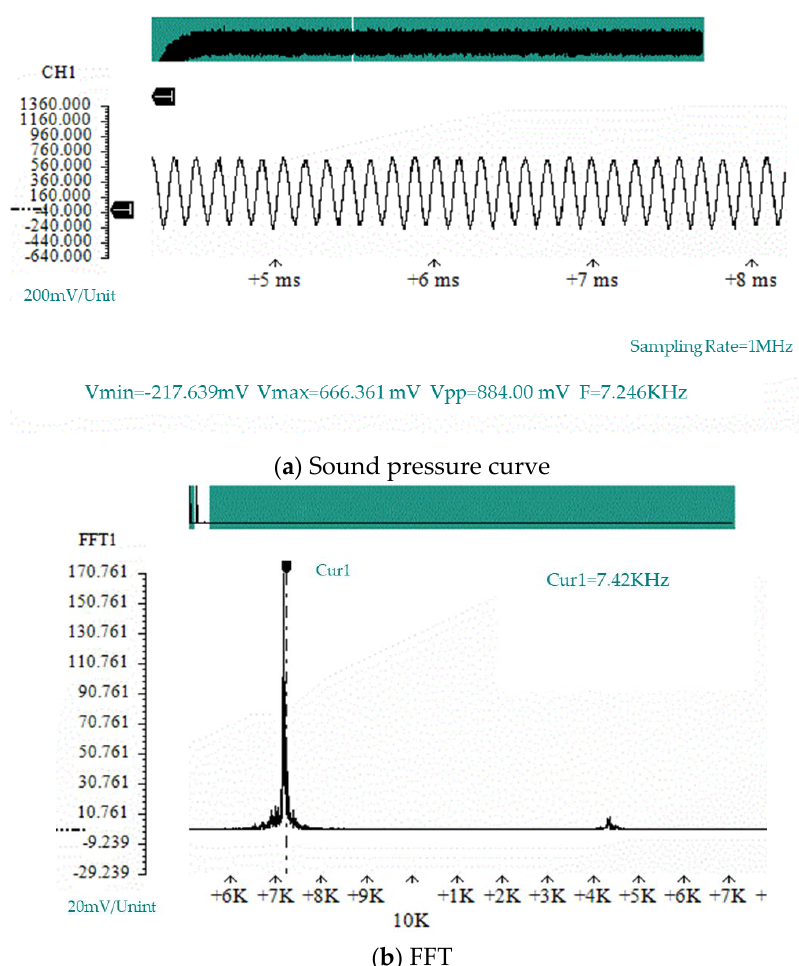
Figure 7. The sound pressure at the bottom of the resonant cavity of prototype #1 when V = 127 m/s.